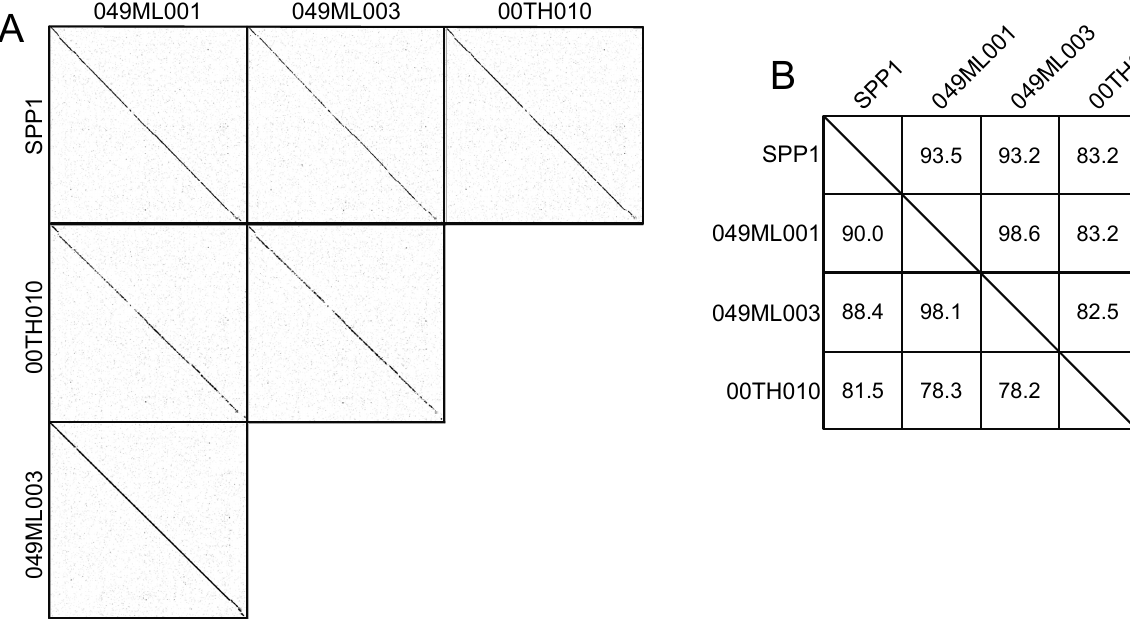
Figure 1. ( A ) Dot plot of the genomes of our three newly isolated SPP1-like phages as well as of SPP1. Plot created using Gepard [49]. ( B ) Average nucleotide identity (ANI; above the diagonal) and average amino acid identity (AAI; below the diagonal) for the SPP1 cluster phages, with each phage compared to the other phages. ANI and AAI were calculated using algorithms from